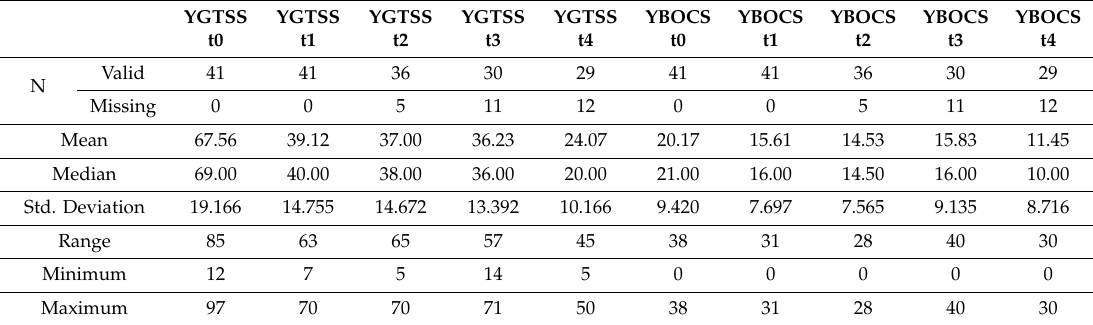
Table 1. Yale Global Tic Severity Scale (YGTSS) and Yale–Brown Obsessive-Compulsive Scale (YBOCS) scores at t0 (baseline) and follow-ups (t1 = 6 months, t2 = 12 months, t3 = 24 months, t4 = 48 months) in the ventralis oralis / centromedian-parascicular nucleus of the thalamus.